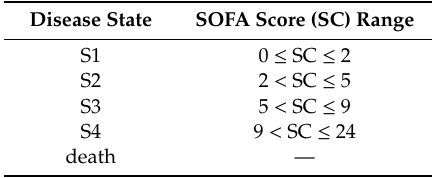
Table 2. Disease states defined by the SOFA